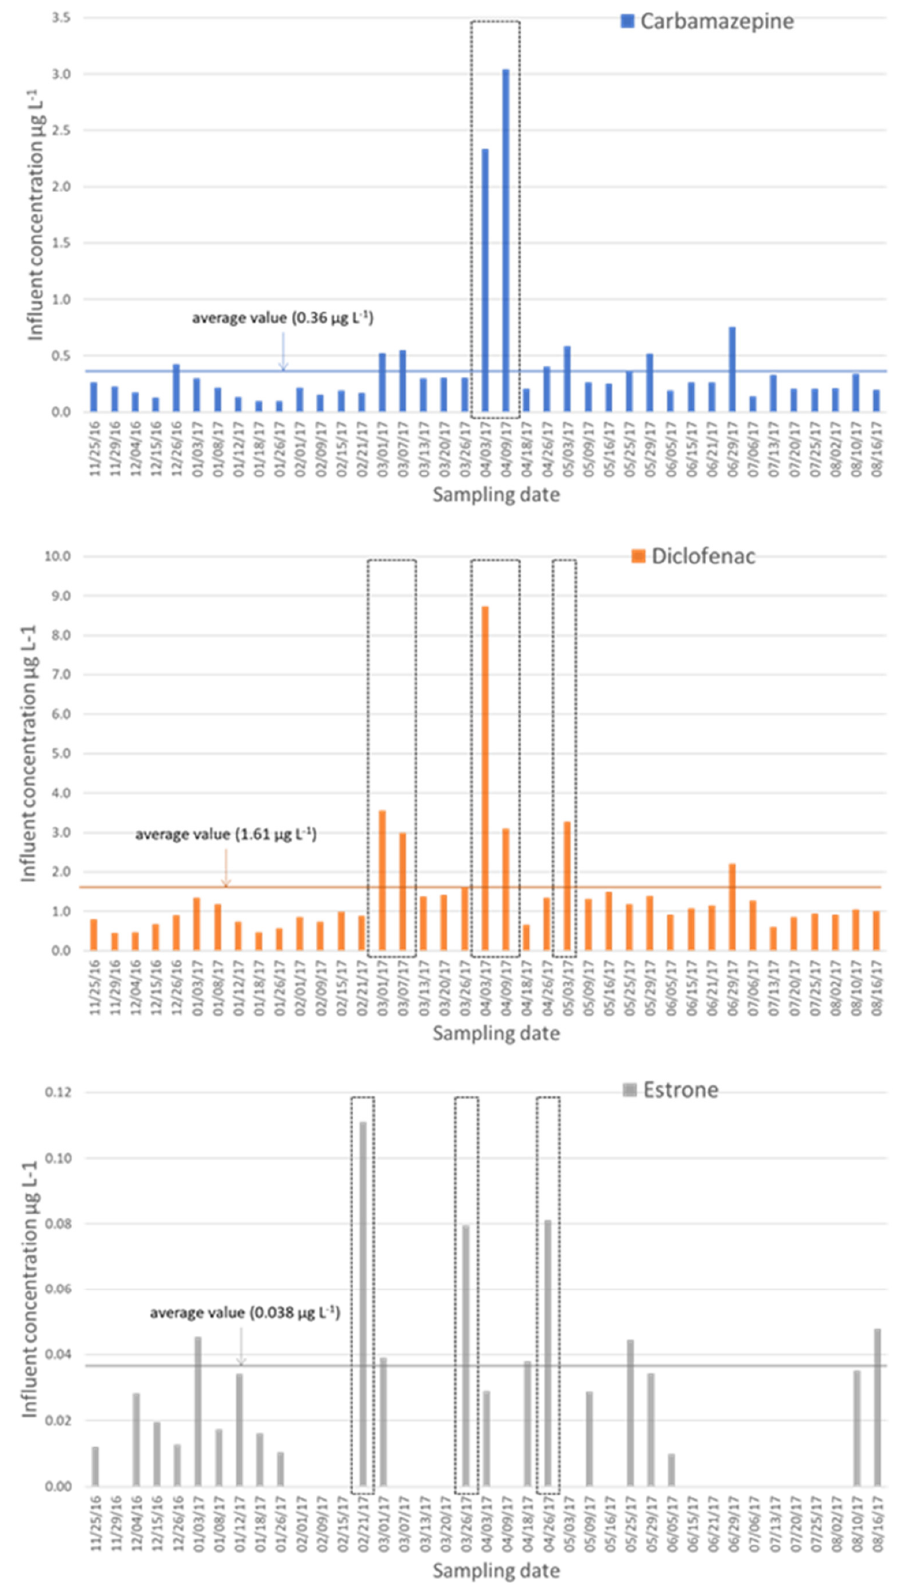
Figure 2. Influent concentrations of the drugs carbamazepine, diclofenac, and estrone for the indicated sampling